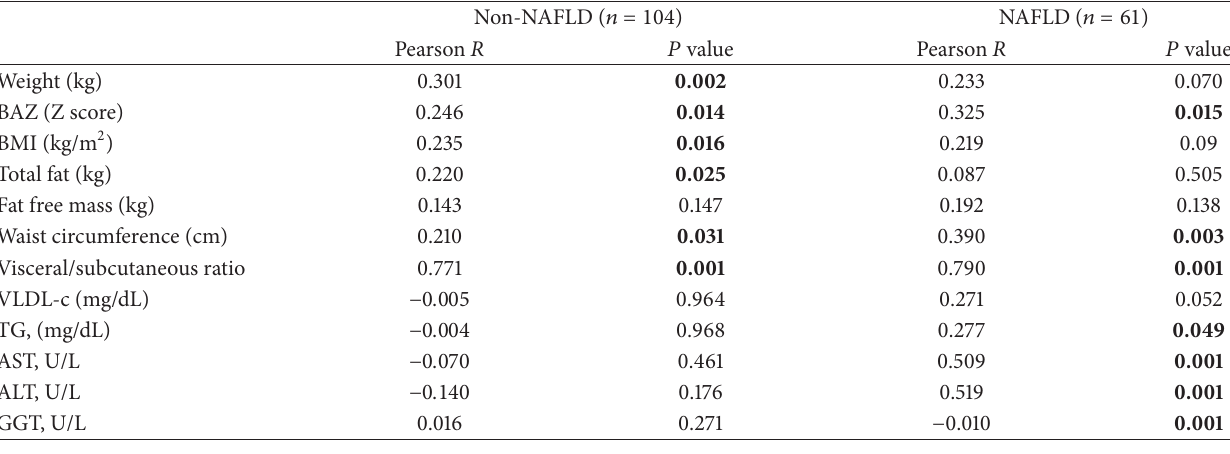
Table 3: Correlations between visceral fat, biochemical, and anthropometric parameters.